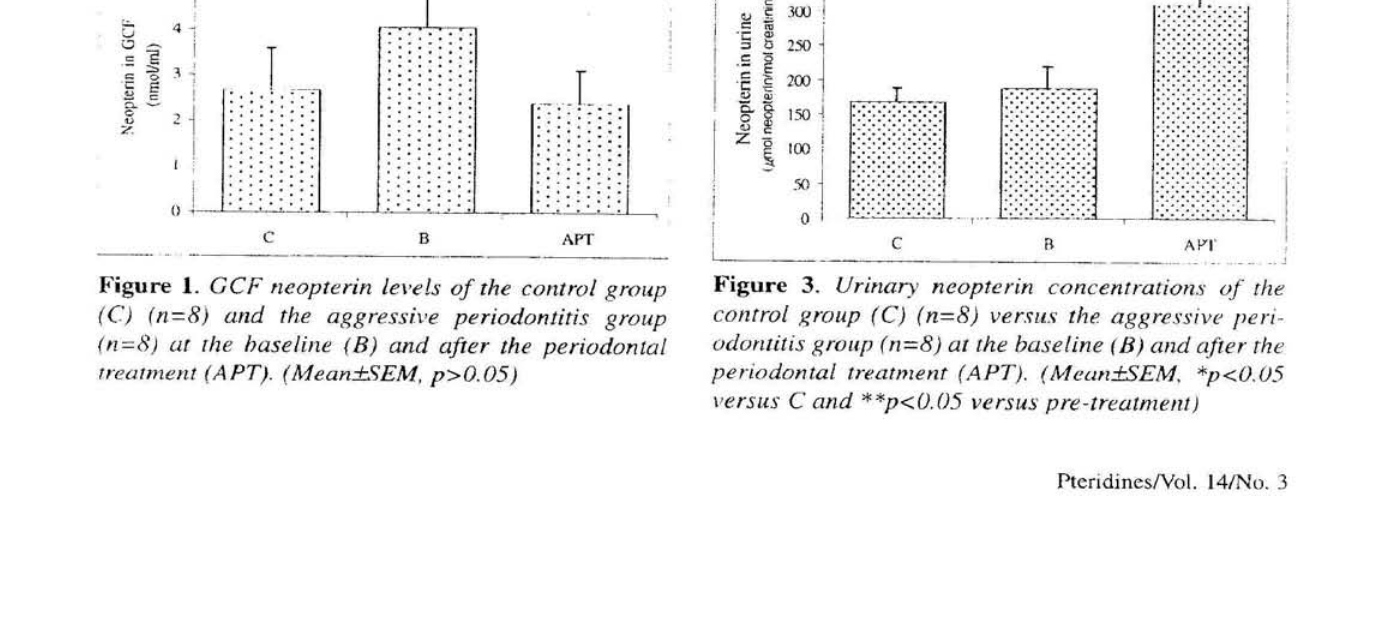
Figure 1. GCF neopterin levels of the control group